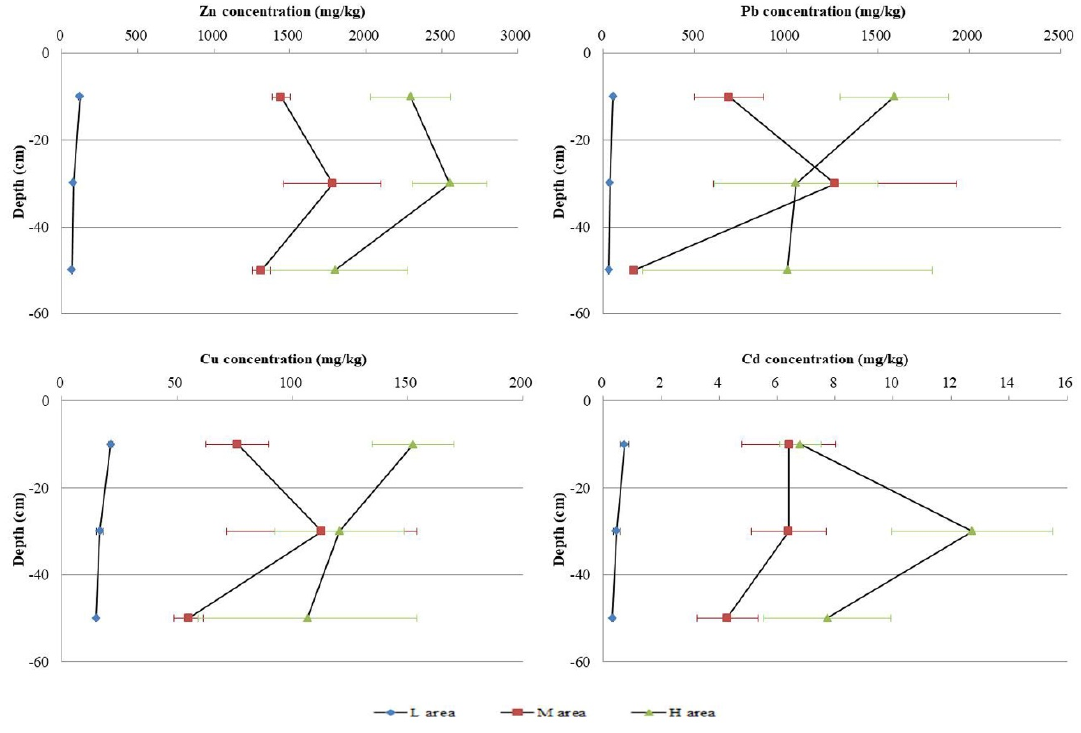
Figure 2. Concentrations of Zn, Pb, Cd, and Cu in different depths of L, M, and H areas in 2015. As highly toxic and the most bioavailable fraction [28], the acid-extractable fraction of Zn, Pb, Cu, and Cd in soil from the study area accounted for 2.40–53.25%, 0.68–26.51%, 0.55–23.32%, and 5.42–75.08% of their total contents, respectively. The acid-extractable fraction of Zn, Pb, Cu, and Cd